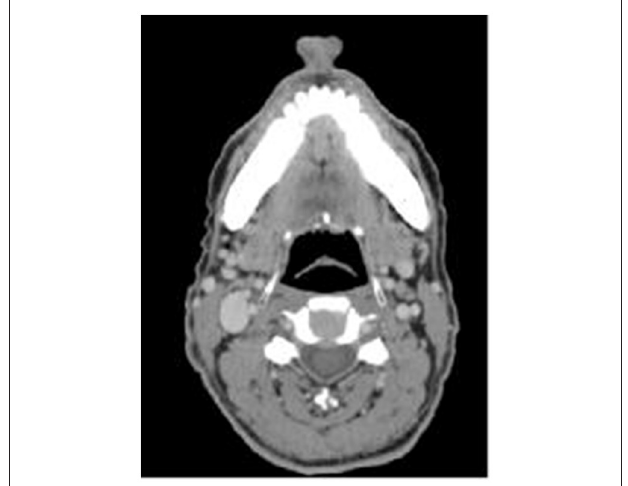
FIGURE 1 | The score of 2 points, with symmetrical bilateral epiglottic fossas and smooth